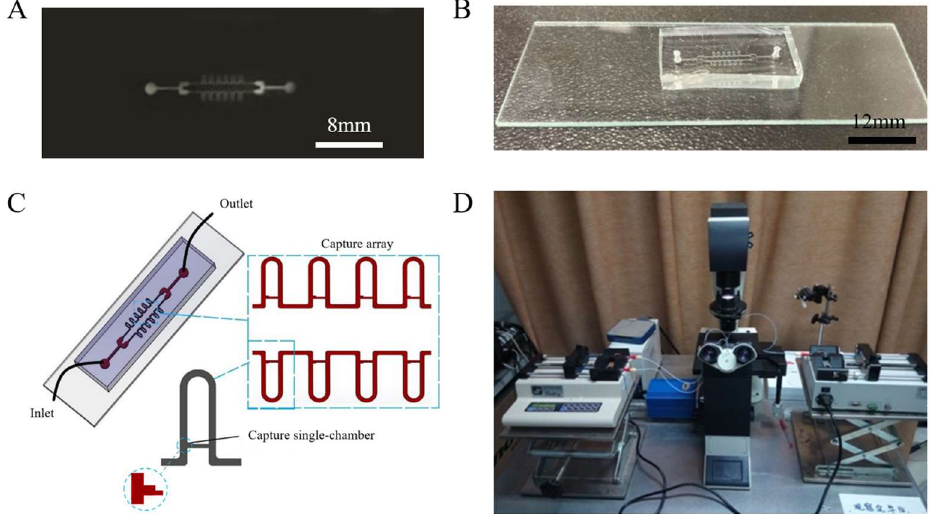
Figure 1. Fabrication and characterization of the capture microfluidic chip. ( A ) Silicon wafer ( B ) Image of a fabricated chip ( C ) Schematic illustration of the capture chip with 2 arrays of 12 chambers ( D ) Observation through the fluorescence microscope.